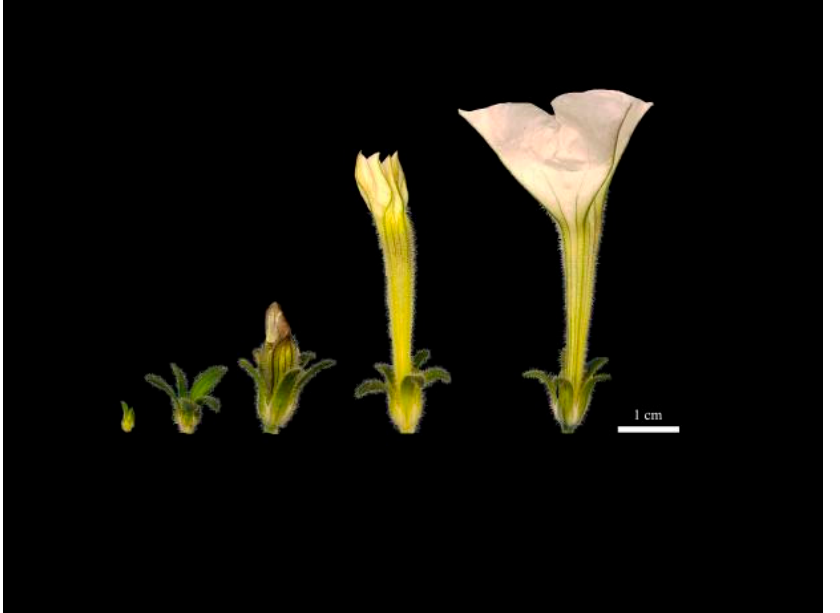
Figure 1. Images of the different studied floral stages of Petunia axillaris . Floral buds were collected at five different developmental stages: buds <0.2 cm, 0.3–1 cm, 1–2 cm, 3–5 cm, and >5 cm (flower open day 0) (from left to right).